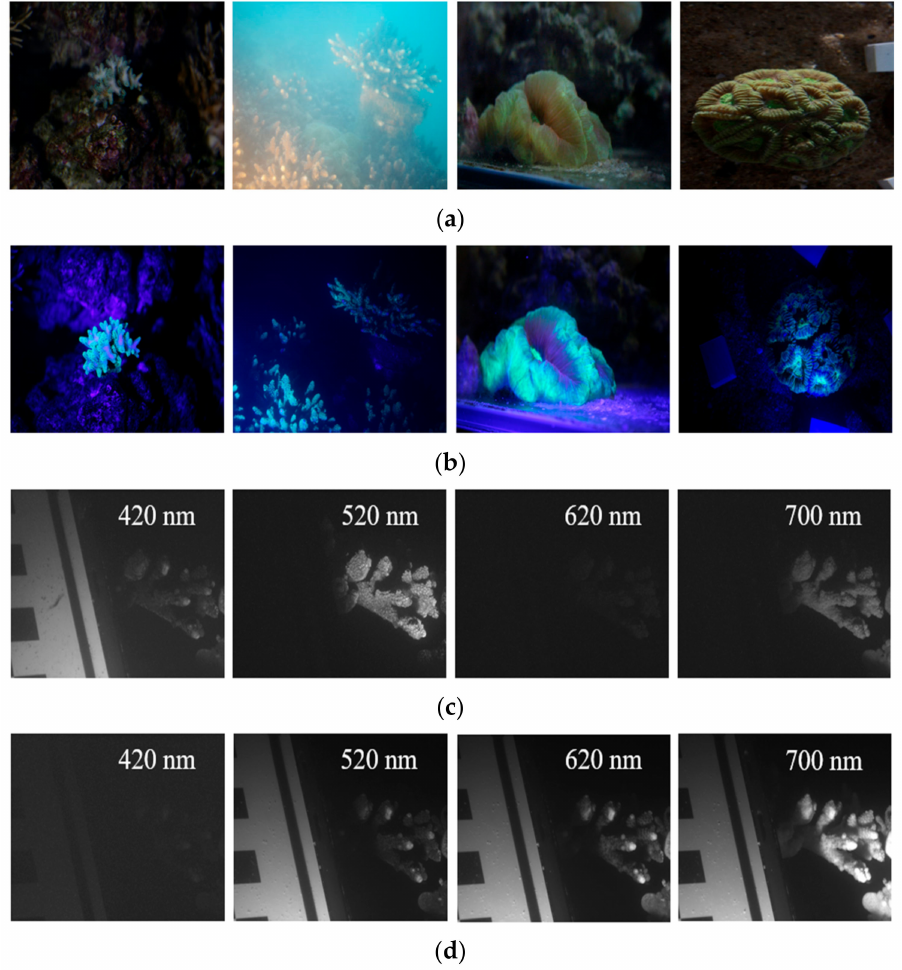
Figure A6. Coral images during the sea trial: ( a ) RGB images under white light; ( b ) RGB images under blue light illumination; ( c ) Spectral images under blue light; ( d ) Spectral images under white light.